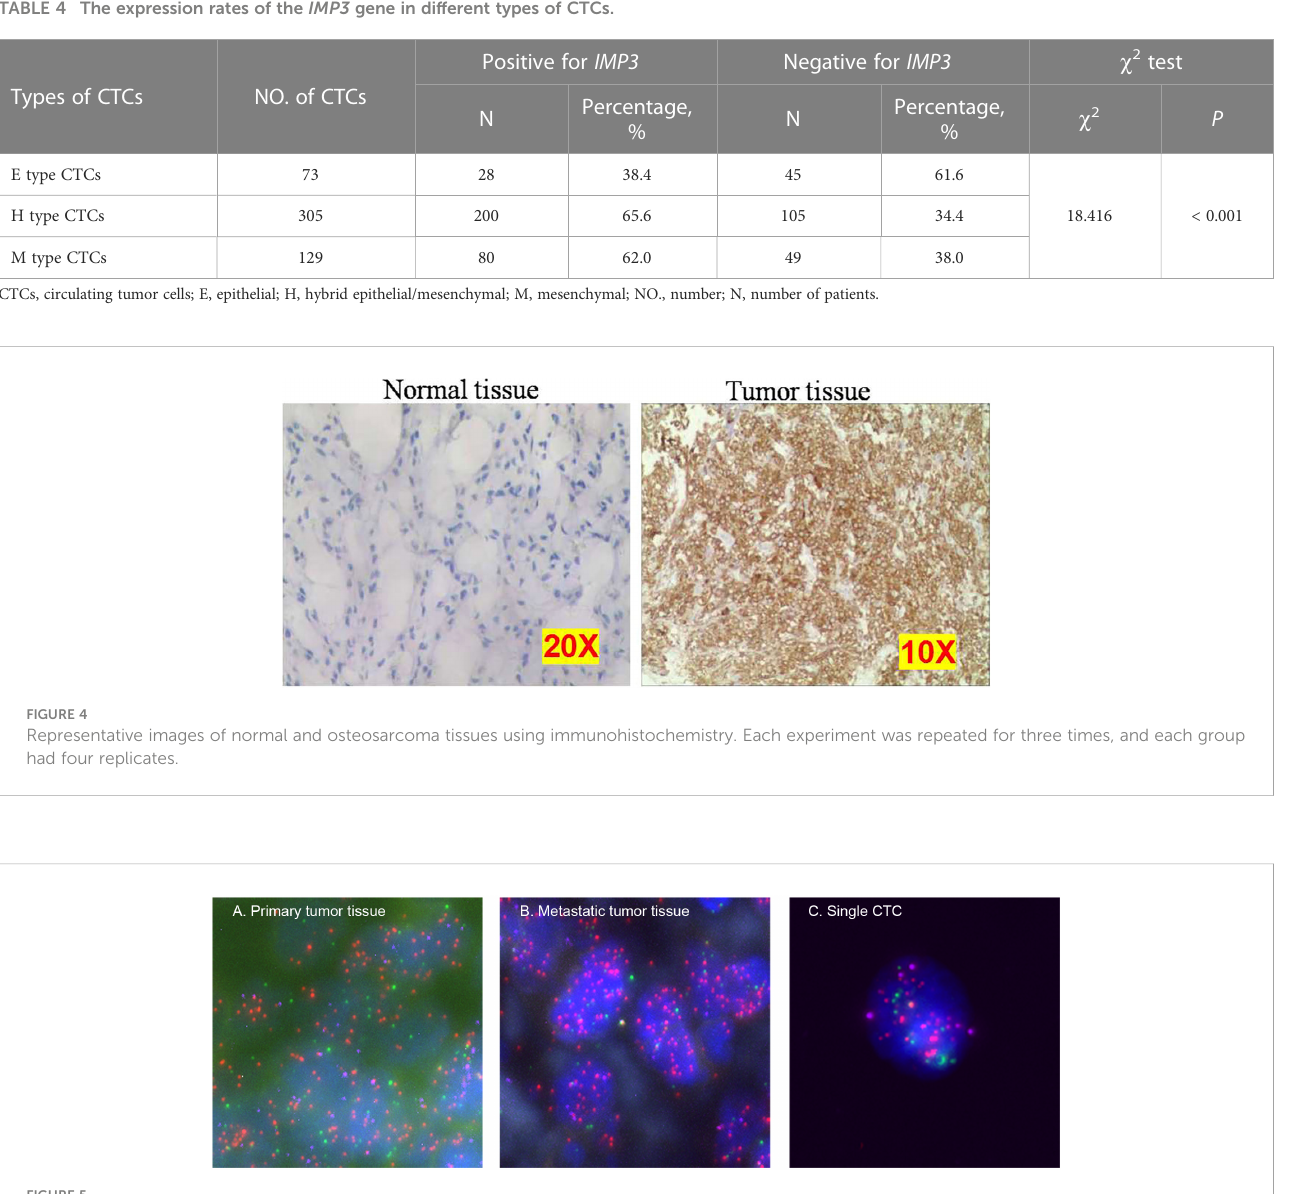
FIGURE 5 Representative images of the osteosarcoma tissues and CTCs based on RNA-ISH staining of epithelial (EpCAM and CK8/18/19, red fl uorescence), mesenchymal (vimentin and Twist, green fl uorescence), and IMP3 (purple fl uorescence) markers. (A) From a primary osteosarcoma tissue, (B) from a metastatic osteosarcoma tissue, and (C) from a single CTC. Each experiment was repeated for three times, and each group had four